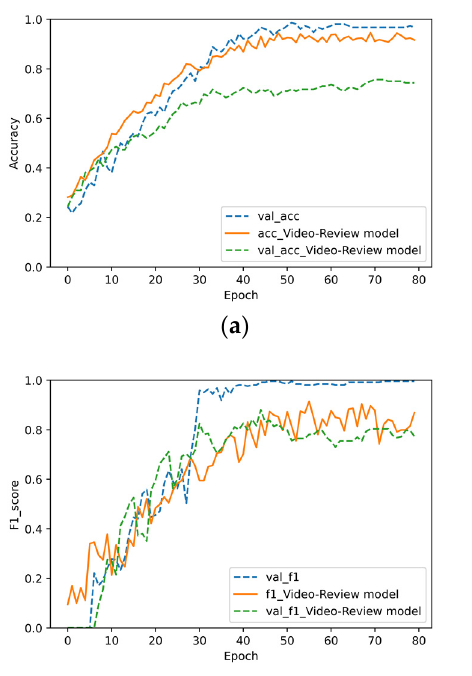
Figure 6. Comparison of the effects of the loss function. The results for ( a ) accuracy, ( b ) recall, and ( c ) F 1 score. ( c ) F 1 score.